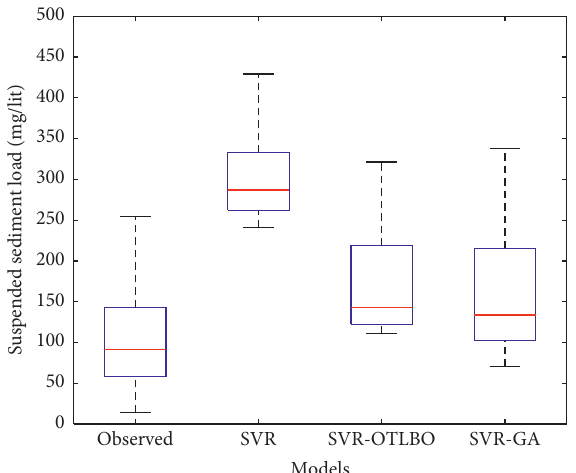
Figure 6: Boxplot of observed and estimated suspended sediment load.